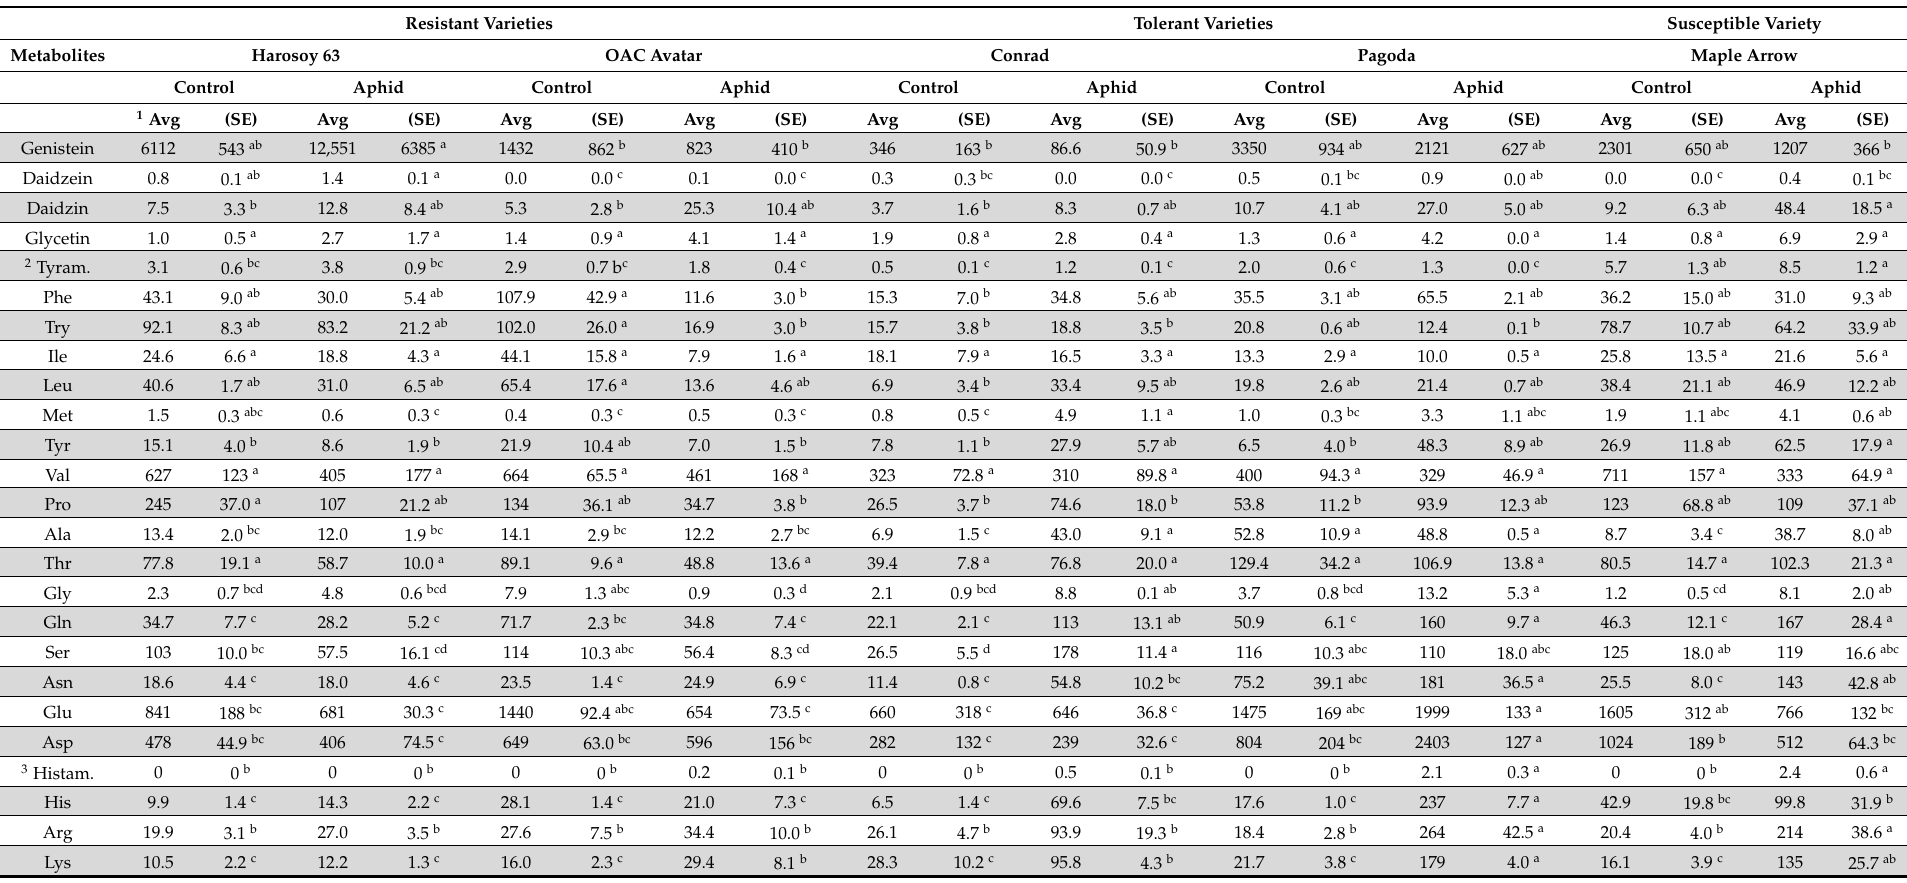
Table 2. The effect of soybean aphid feeding on the concentrations of isoflavones, amino acids, and other bioactive compounds in the leaves of one susceptible, two resistant, and three tolerant soybean cultivars after 4